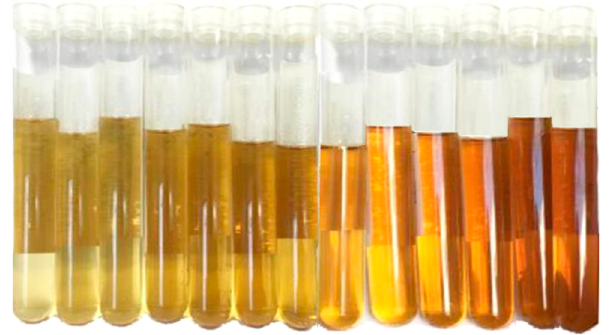
Figure 2. S eries of oil samples aged from 0 to 3000 h (step 250 h) through the hydraulic test